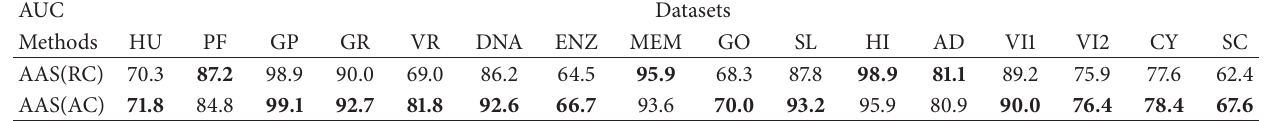
Table 11: Comparison between AAS(RC) and AAS(AC).